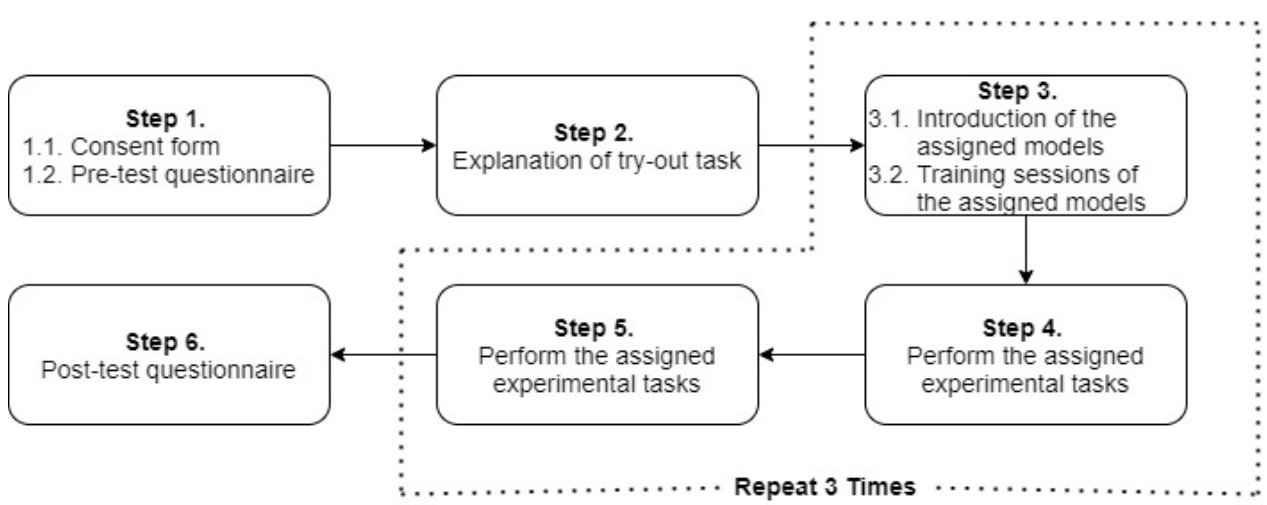
Figure 4. Experiment procedure.